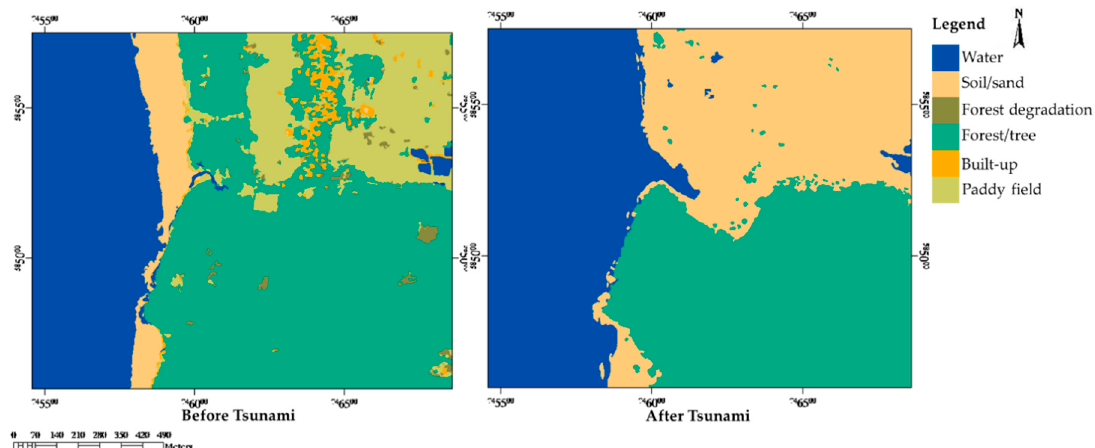
Figure 8. The resultant images obtained by the RF classifier using the Experiment II data set.